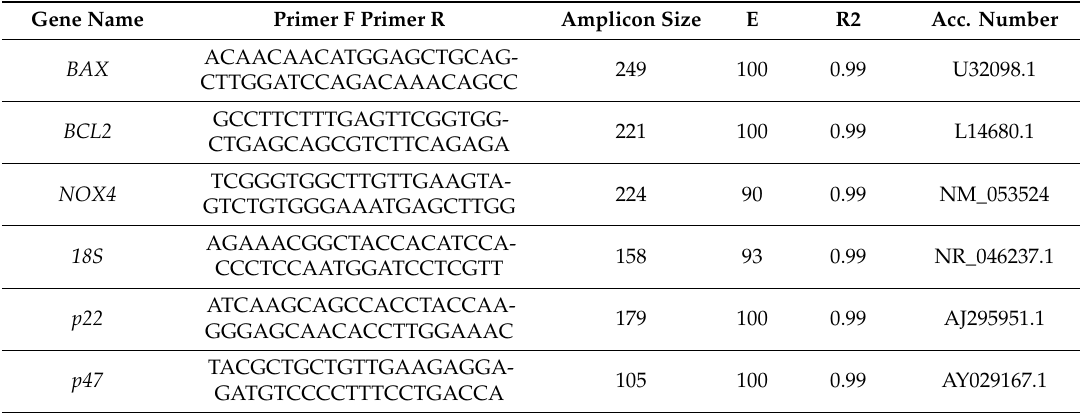
Table 1. Gene names, primer forward (F) and reverse (R), amplicon size, oligo e ffi ciencies (E) and correlation factors (R 2 ), and GenBank accession